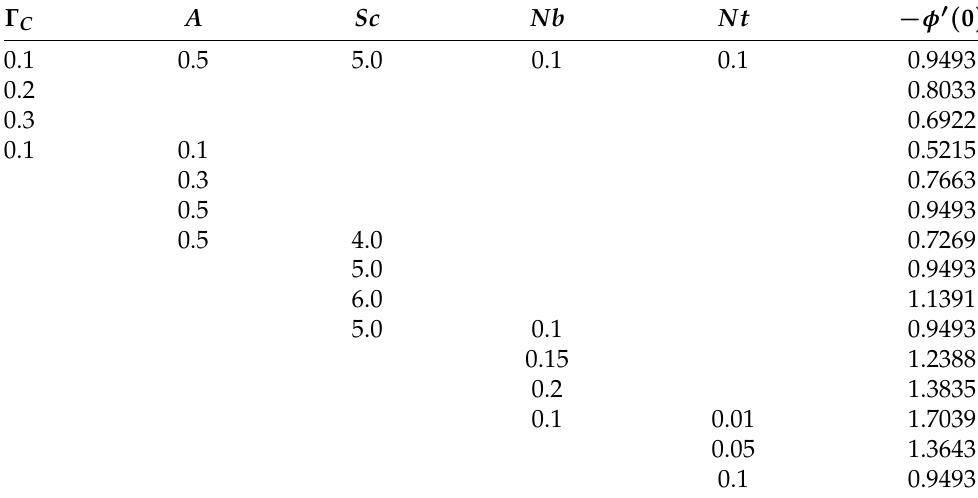
Table 5. Results for − φ (cid:48) ( 0 ) .